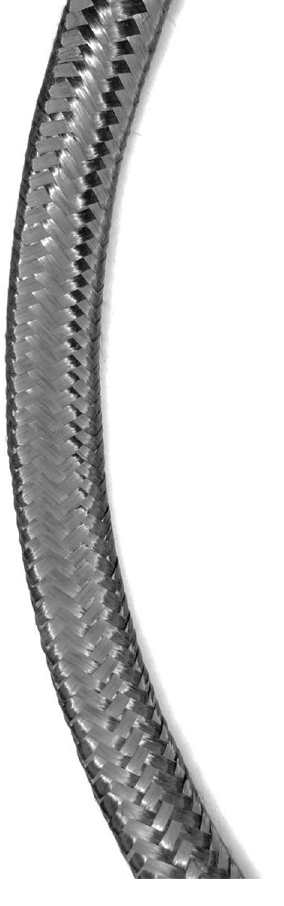
Figure 5: Actual image of the braided